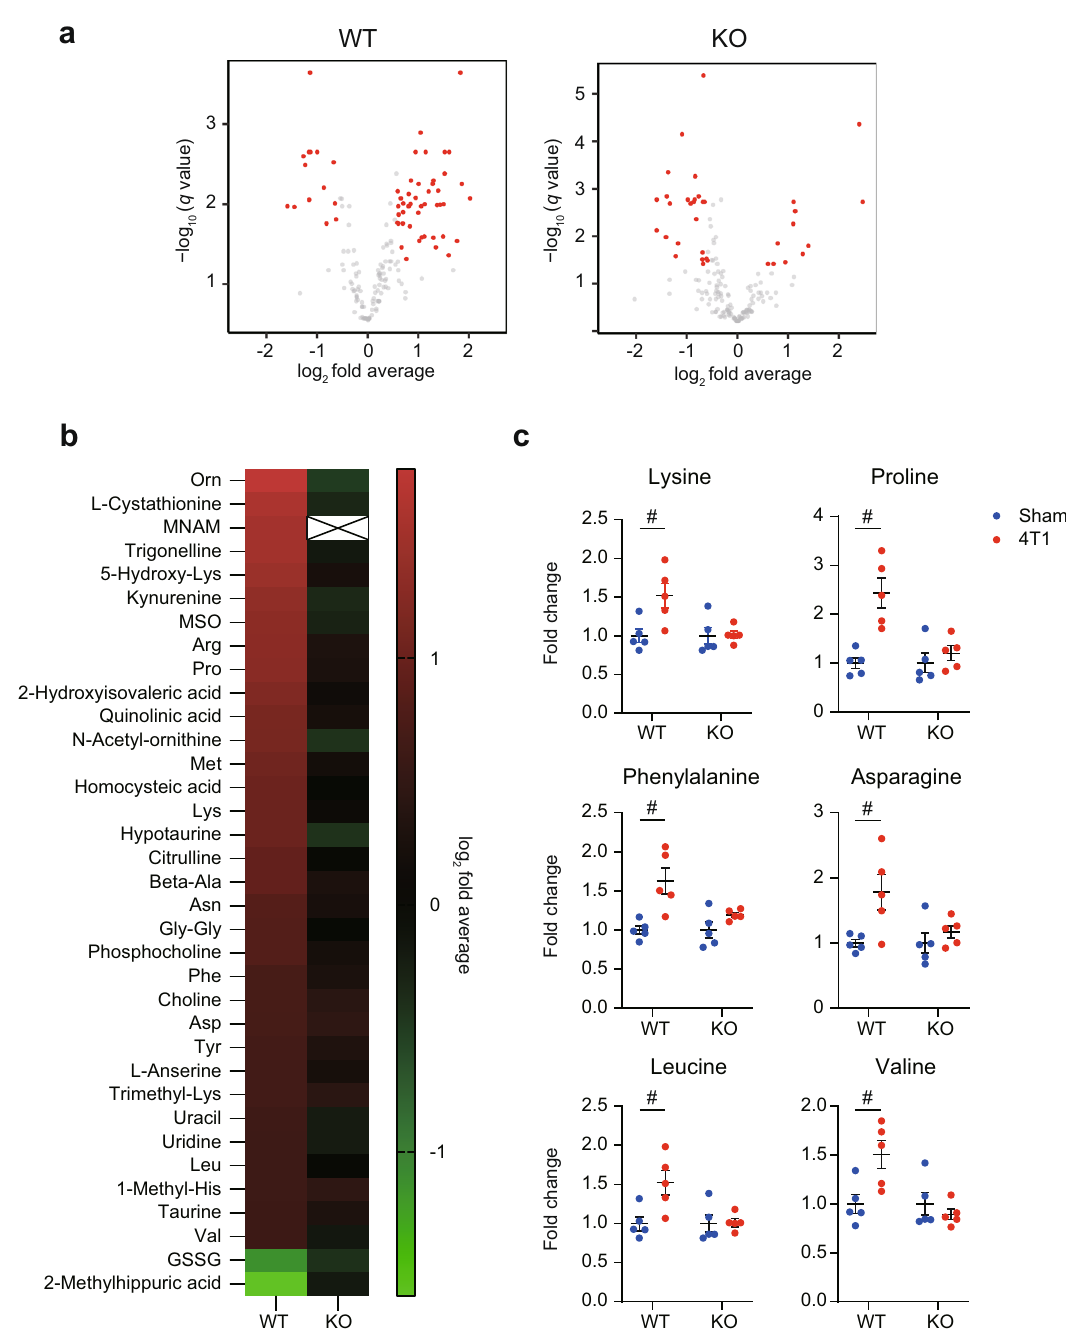
Fig. 4 Nnmt deletion buffers metabolic changes caused by 4T1. a Metabolome experiments for the livers of sham-operated mice and 4T1-bearing mice in WT and Nnmt KO (14 days after 4T1 transplantation). Volcano plots (log 2 fold average (4T1/sham) versus – log 10 ( q value)) of WT (left) and Nnmt KO (right) are shown. Metabolites showing more than 1.5-fold change with q < 0.05 are highlighted in red. n = 5. b Heatmap representation of metabolites that are signi fi cantly affected in WT (left column) but not in Nnmt KO (right column). n = 5. c Representative plots of “ rescued ” metabolites are shown in b . Data from six representative amino acids are shown. Averaged fold change data normalized to the sham group in each genotype are presented as the mean ± SEM. #; more than 1.5-fold change with q < 0.05. n = 5. Source data are provided as a source data fi